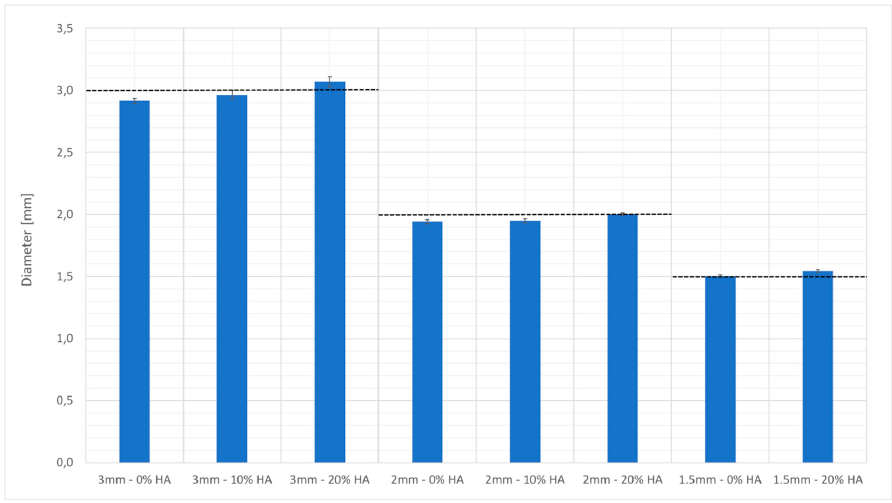
Figure 4. Nominal diameter versus the real diameters of the beads built by vat photopolymerization. The SEM observations highlighted that when the sizes of the uncharged beads decreased, a localized wall subsidence could occur in the anchoring point during the support removal. An example of this is shown in Figure 5A–B. This phenomenon was not observed for the reinforced beads. In this latter case, Figures 5C and 4D show the non- uniform distribution of HA, where the reinforcing particles were more numerous at the holes’ inner surfaces. The laser’s path and characteristics explain the higher concentrations of HA surrounding the holes. The laser can be characterized by a gaussian distribution of the energy across the spot area (TEM 00 laser). Typically, the photopolymer resin requires a UV inhibitor, and its function is to prevent UV rays from penetrating excessively into the already-consolidated layers, which would cause solidification of the resin in undesired areas. If Equation (2) is considered, the presence of HA could partially diminish the energy available for the photopolymer, and therefore, at the periphery of the spot, where the incident energy was lower because of the Gaussian distribution, the reinforced resin could not reach an energy value sufficient to trigger polymerization. This would turn into a different degree of polymerization in the core and contour areas. Around the hole, the material under the peripheral spot area toward the center of the hole would not be completely polymerized, while that at the antipodes (but facing the fill zone) would undergo complete polymerization due to the adjacent passes in the core region. It can be conjectured that, in the washing phase, the non-polymerized material would be removed, whereas the HA may remain attached to the solidified resin. The post-processing phase in the UV oven would then consolidate the bond. Therefore, the observed higher concentration of HA around holes may have been due to the subtraction of the matrix from the boundary of the hole (Figure 6).